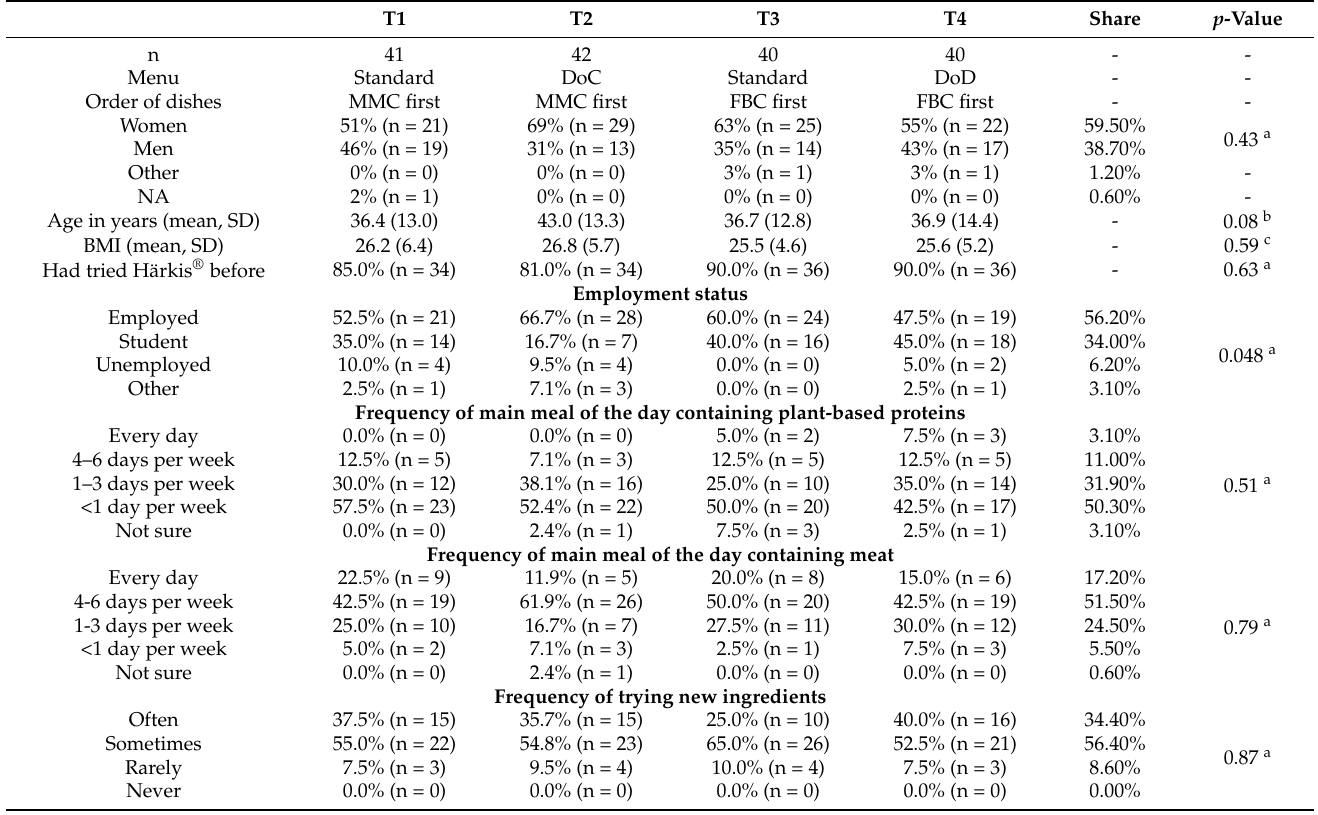
Table 1. Characteristics of the participants (n = 163) in each treatment (T).